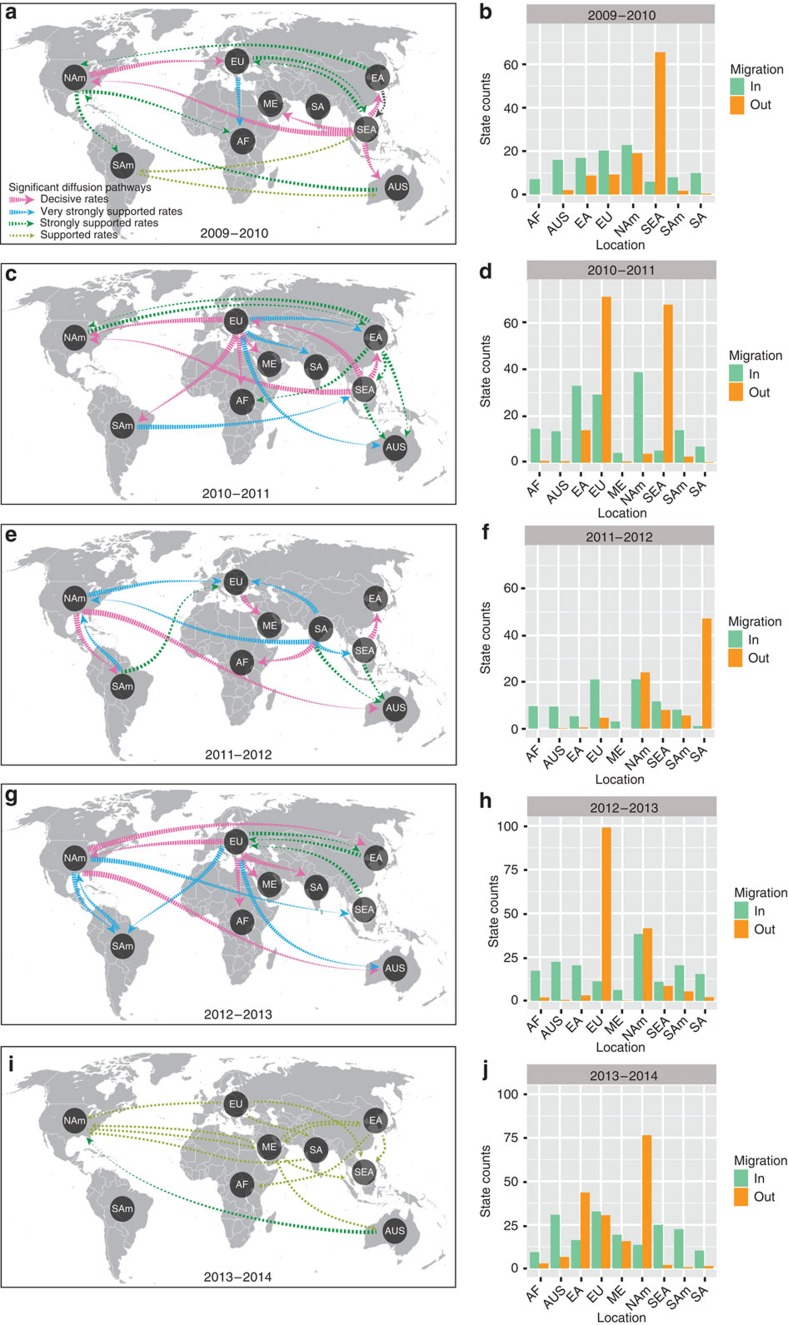
Spatial diffusion of H1N1/2009 viruses.Spatial diffusion pathways and histograms of total number of state transitions for (a,b) 2009–2010, (c,d) 2010–2011, (e,f) 2011–2012, (g,h) 2012–2013 and (i,j) 2013–2014. Global epidemic year was defined as October to the following September based on observed epidemics in Fig. 3a. Significant epidemiological unidirectional pathways from one location to another are indicated on the maps. Thickness of coloured lines represents statistically supported migration rates with a mean indicator of >0.5: pink arrows, decisive rates with BF≥1,000; blue arrows, very strongly supported rates with 100≤BF<1,000; dark green arrows, strongly supported rates with 10≤BF<100; and light green arrows, supported rates with 3≤BF<10. AF, Africa; AUS, Australia; EA, East Asia; EU, Europe; NAm, North America; SEA, Southeast Asia; SAm, South America; SA, South Asia.